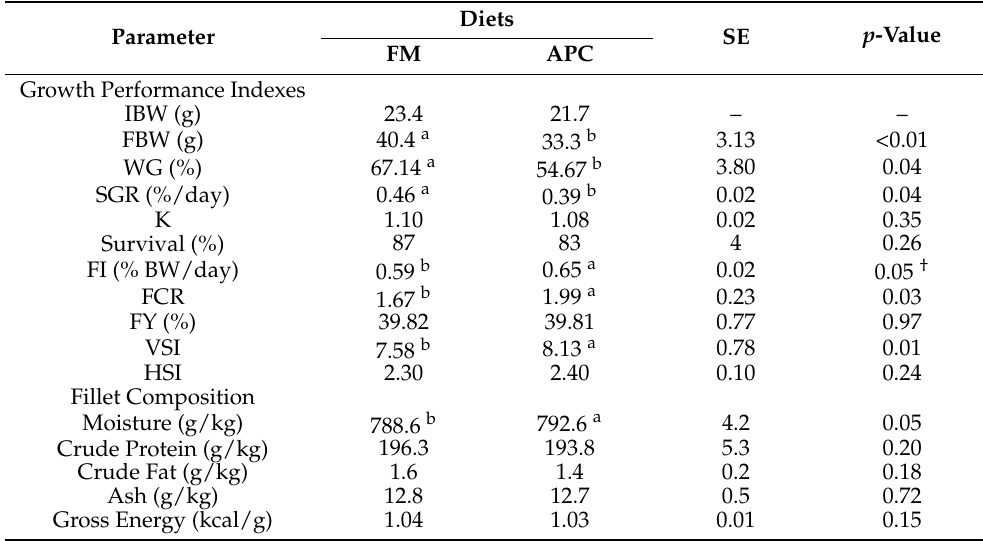
Table 3. Effects of replacing fishmeal (FM) with alfalfa protein concentrate (APC) in a diet for yellow perch on growth performance and fillet composition.